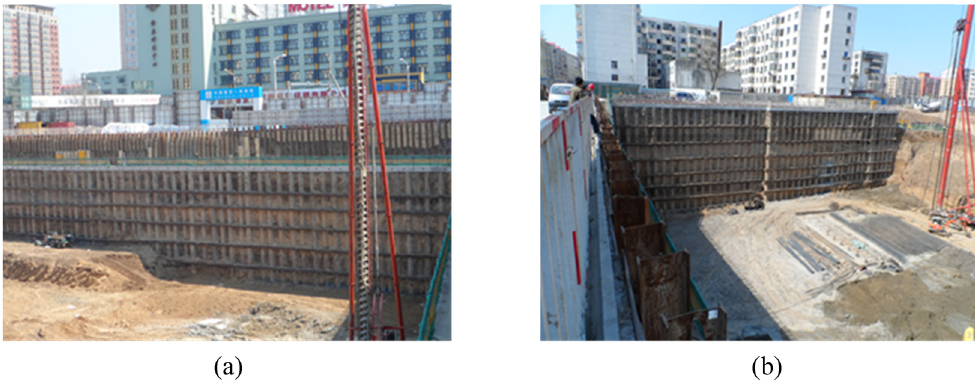
Figure 1: Supporting diagram of the foundation pit. ( a ) East side and ( b ) west